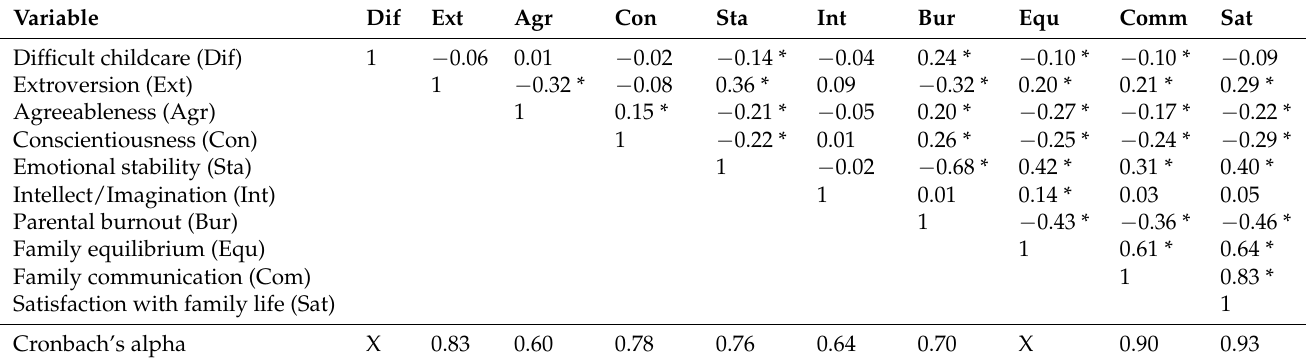
Table 2. Correlation Matrix and Scales